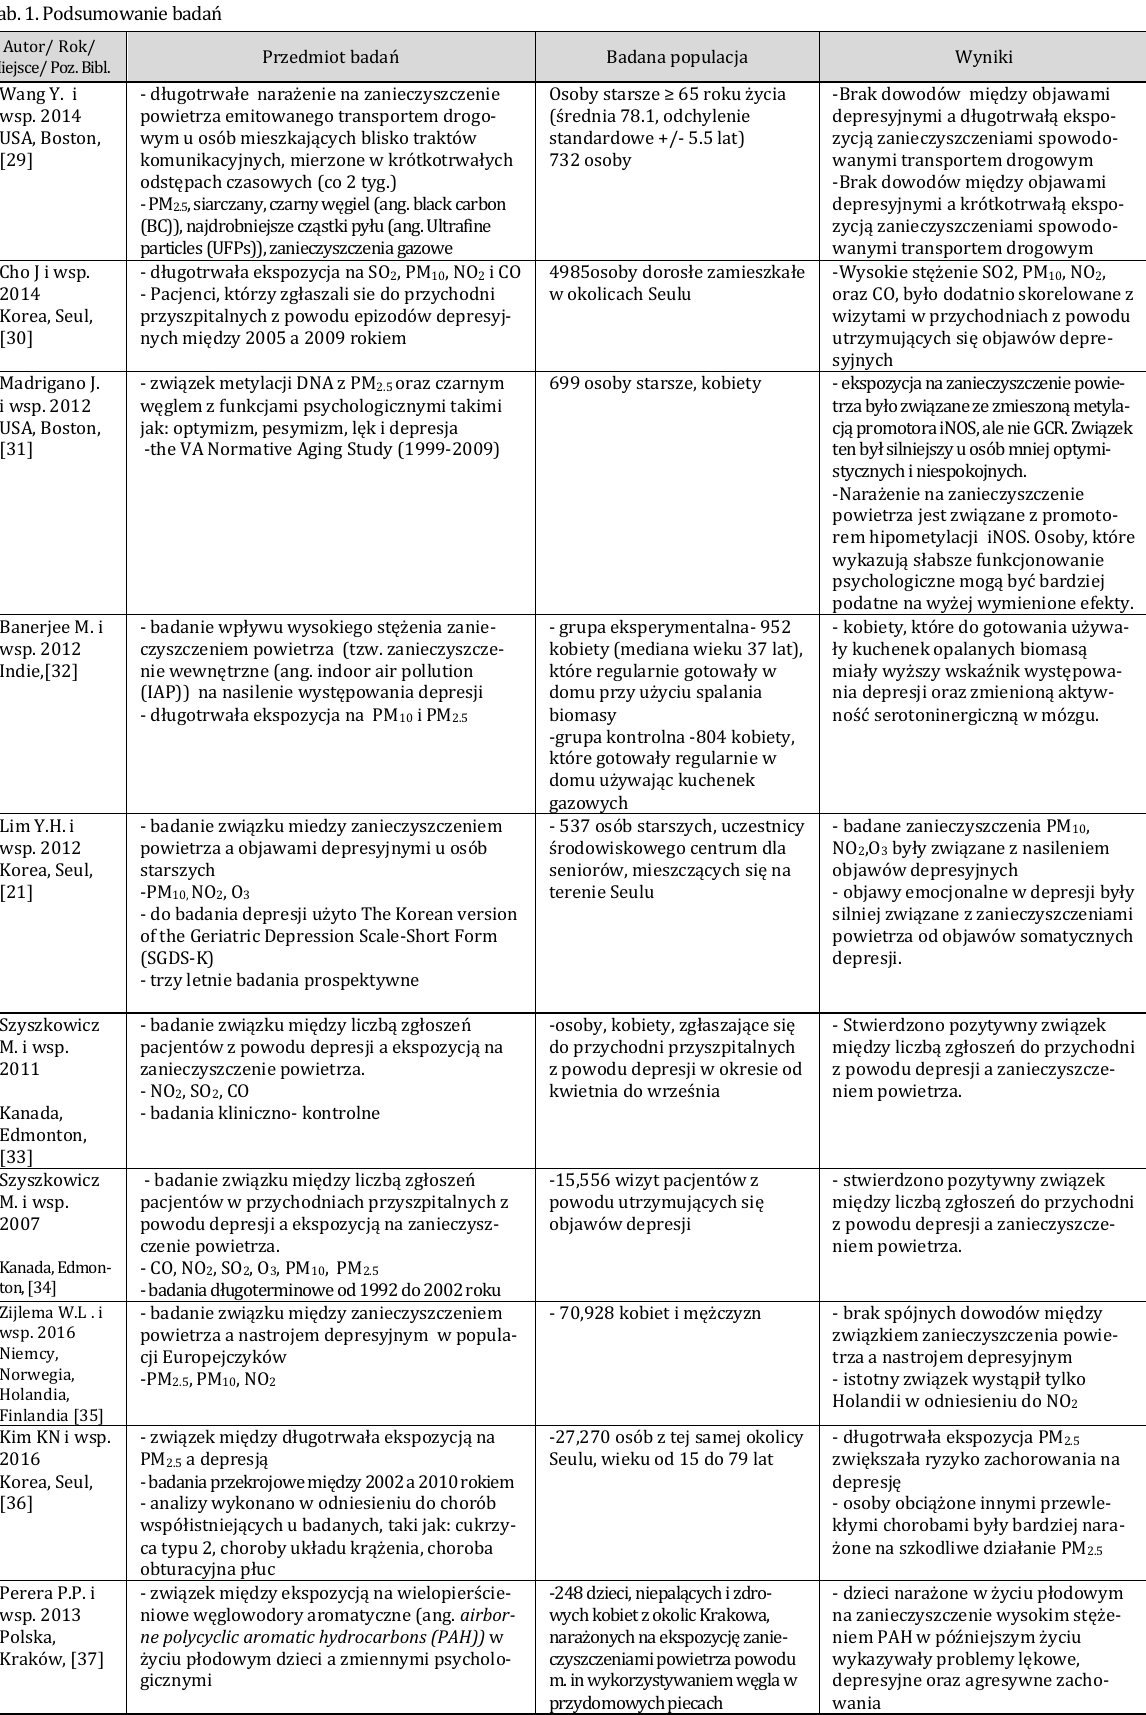
Tab. 1. Podsumowanie